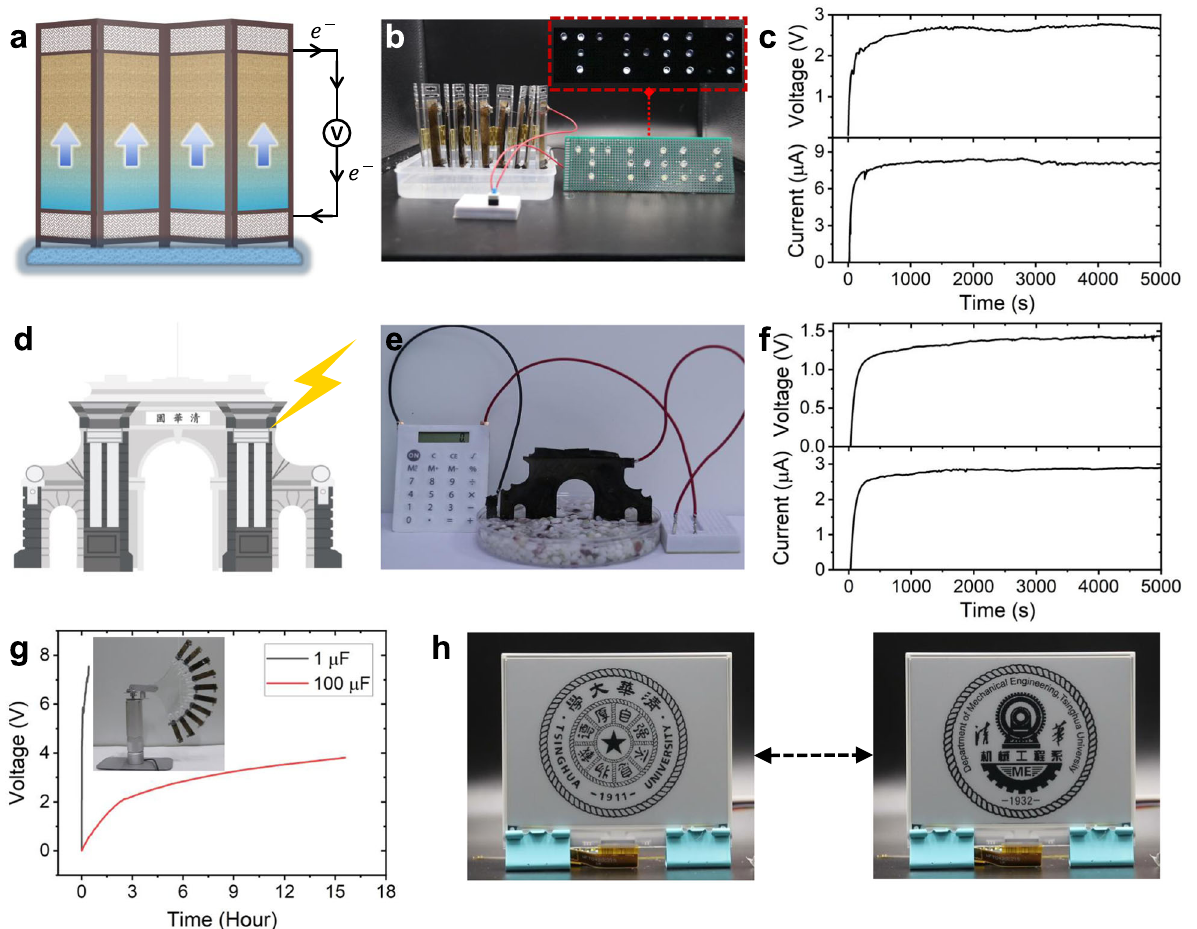
Fig. 7 | Application demonstrations of 2D-WEGs. a Schematic of a waterscape screen generating electricity by spontaneous water transport. b Optical photo- graph of nineteen LEDs powered by a waterscape screen with 10 integrated 2D- WEGsand the inset b shows19 LEDs being litup. c The V oc and I sc aregeneratedby the waterscape screen with 10 integrated 2D-WEGs when the bottom is in contact with water. d Schematic illustration of electrical output produced by watering a small architectural landscape designed by a 2D-WEG. e A commercial calculator is